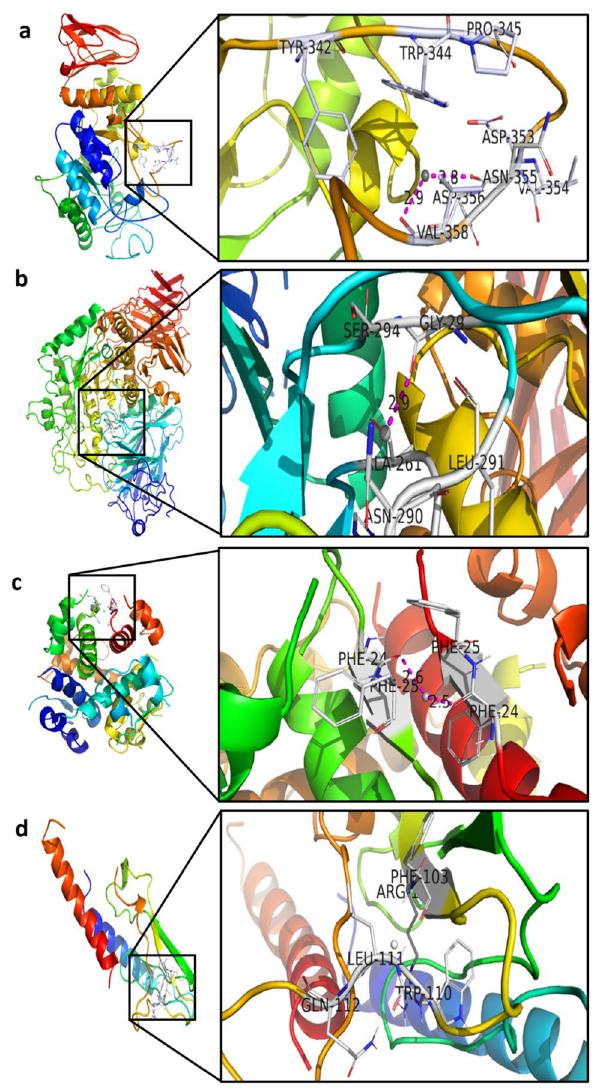
Figure 6. Molecular docking and Interactions between silver atoms and the amino acid residues of ( a ) α-Amylase ( b ) α- Glycosidase ( c ) Insulin ( d ) Glucagon (The binding of silver molecule with protein was shown in left side and the interaction between the amino acids residues and silver atom was shown in right side).